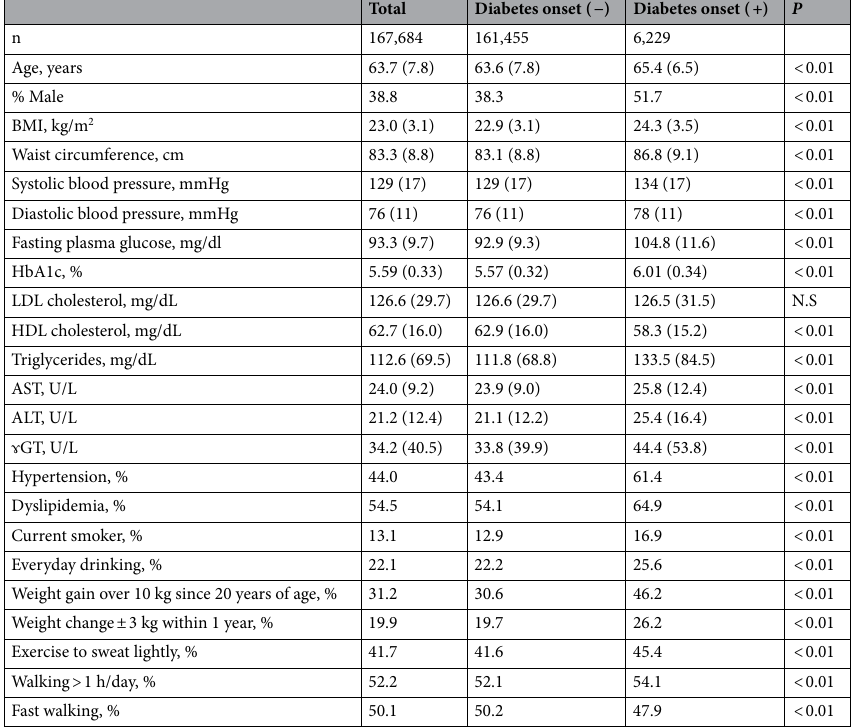
Table 1. Baseline characteristics of participants. AST aspartate aminotransferase, ALT alanine aminotransferase, γGT γ-glutamyl transpeptidase, N.S. not significant. Values are Mean (SD) or %. P